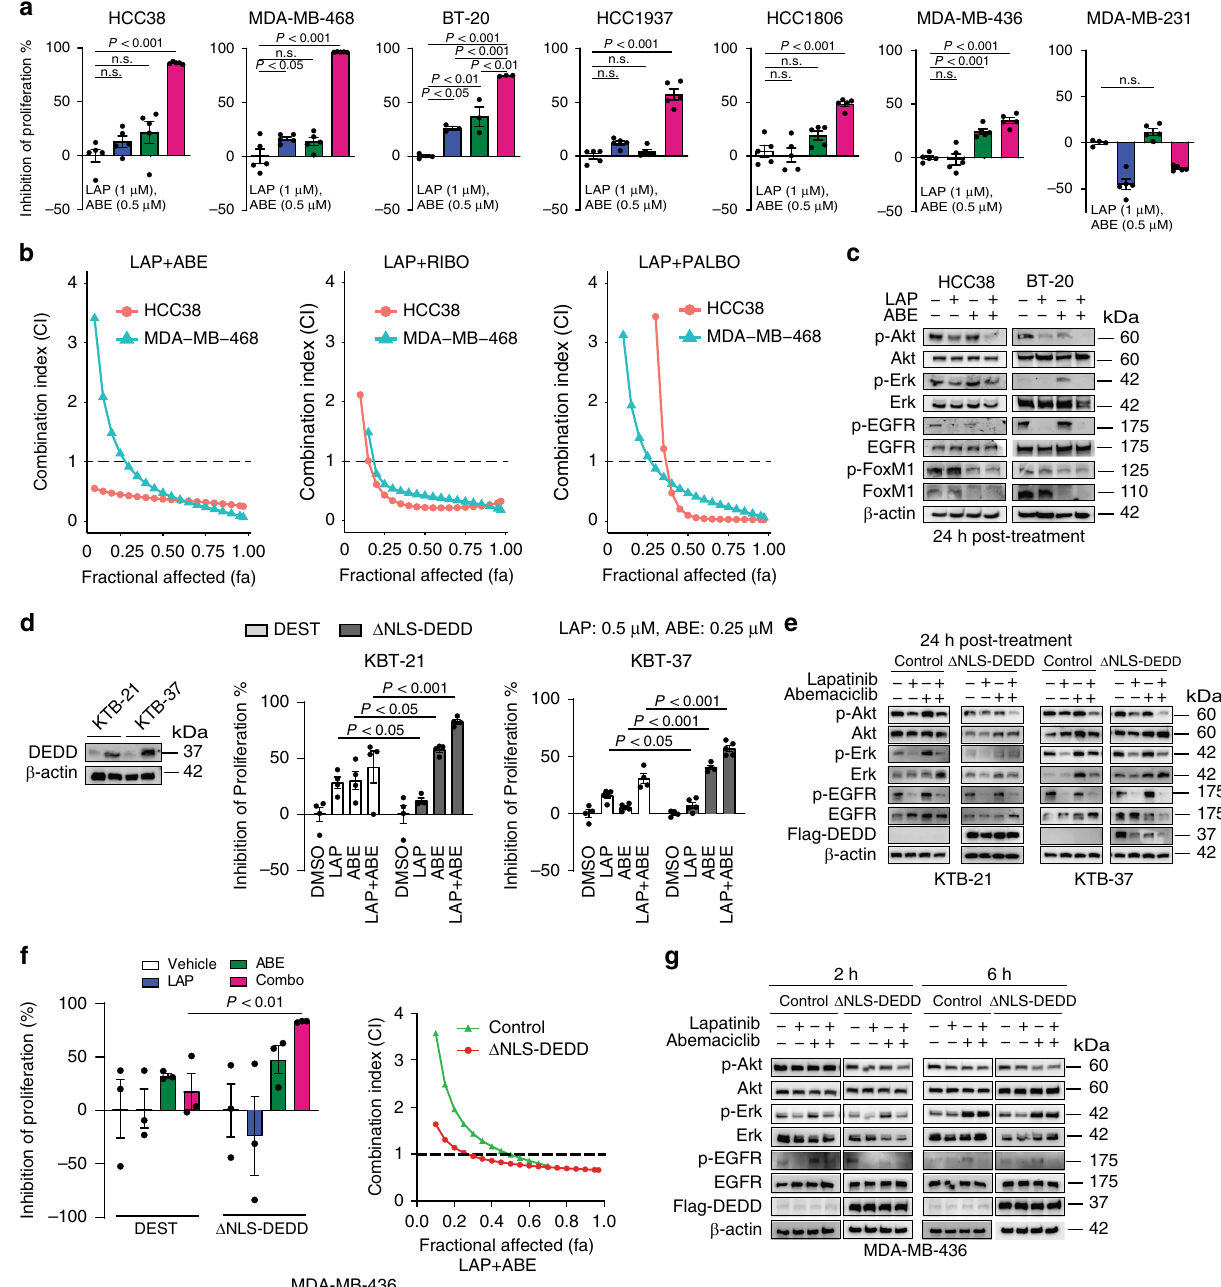
Fig. 5 Cyclin-dependent kinases 4/6 (DK4/6) inhibitor synergizes with epidermal growth factor receptor (EGFR) inhibitor to suppress triple-negative breast cancer (TNBC) proliferation. a MTT (3-(4,5-dimethylthiazol-2-yl)-2,5-diphenyltetrazolium bromide) assay showing the inhibition of cell proliferation of TNBC cell lines treated with dimethyl sulfoxide (DMSO), lapatinib (LAP, 1 µ M), abemaciclib (ABE, 0.5 µ M), or Combo (LAP + ABE) for 48 h. b Drug synergism analysis showing synergism index on different FA (fraction affected) in TNBC cell lines. Dosage ratio: LAP:ABE = 4:1; LAP:RIBO (Ribociclib) = 2:1; LAP:PALBO (Palbociclib) = 1:2. c Western blots showing downstream signaling changes in TNBC cell lines after designated treatment for the indicated time. d , Left: Western blots showing cytosolic DEDD expression after lentiviral infected Δ NLS- DEDD in KTB cell lines. Right: MTT assay showing inhibition of proliferation of DEST- or Δ NLS- DEDD -expressing KTB cells treated with DMSO, LAP (0.5 µ M), ABE (0.25 µ M), or Combo for 48 h. e Western blots showing EGFR, Akt, and Erk signaling changes in DEST- or Δ NLS- DEDD- expressing KTB cells treated with DMSO, LAP (0.5 µ M), ABE (0.25 µ M), or Combo for 24 h. f , Left: MTT assay showing the inhibition of proliferation of MDA-MB-436 cells expressing or not expressing cytosolic DEDD after designated treatment. Cells were treated as in d . Right: Drug synergism analysis showing synergism index on different FA with the dosage ratio of 4:1 (LAP:ABE). g Western blots showing EGFR, Akt, and Erk signaling changes in MDA-MB-436 cells expressing or not expressing cytosolic DEDD treated with DMSO, LAP (1 µ M), ABE (0.25 µ M), or Combo for indicated hours. All quantitative data were generated from a minimum of three replicates. Error bars represent means ± s.e.m. For a , P values were derived from one-way analysis of variance (ANOVA) with multiple comparison test. For d , f , P values were derived from two-tailed t test. n.s., not signi fi